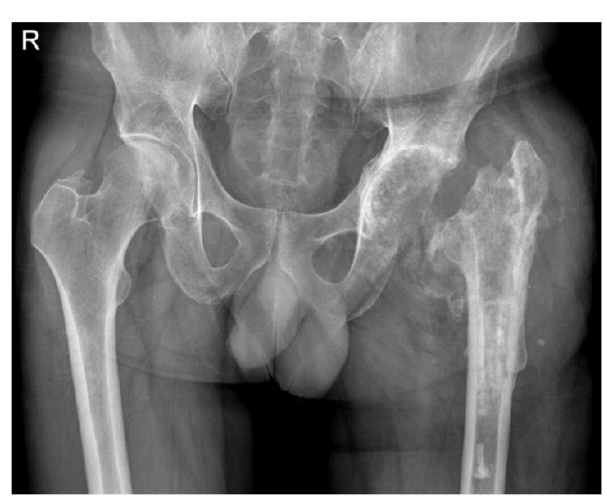
Figure 3: Girdlestone resection arthroplasty after an infected total hip prosthesis on the left side.